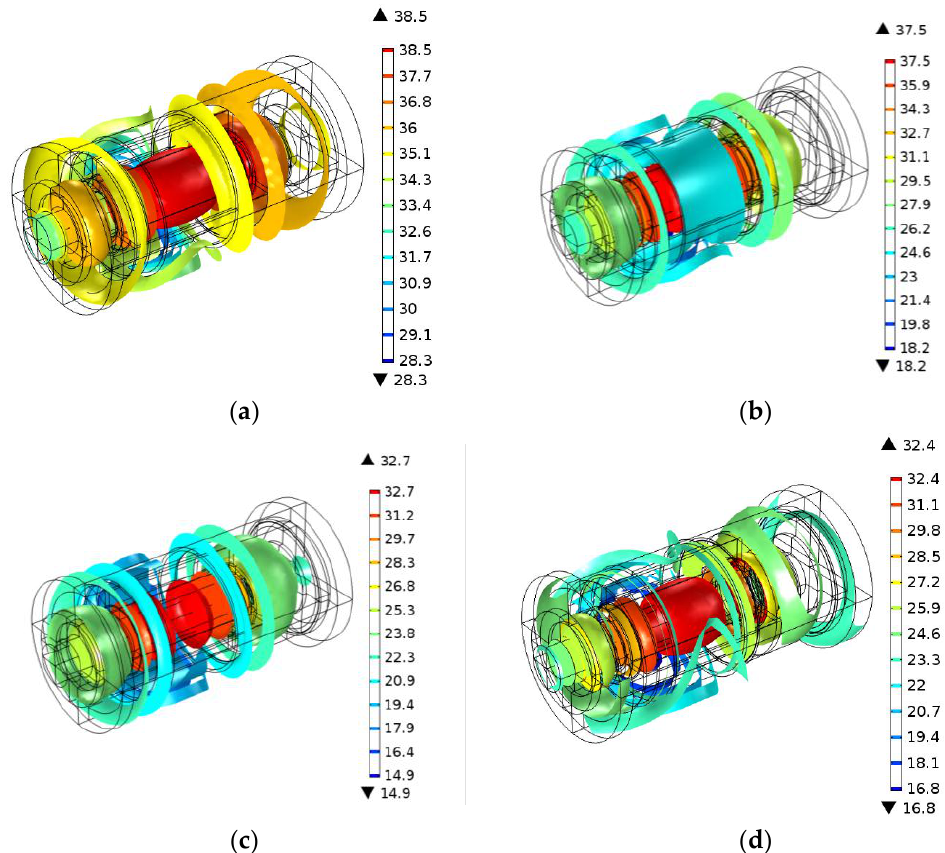
Figure 8. Isotherm of the motorized spindle at 10,000 rpm. ( a ) 25 iterations, ( b ) 50 iterations, ( c ) 75 iterations, ( d ) 100 iterations.